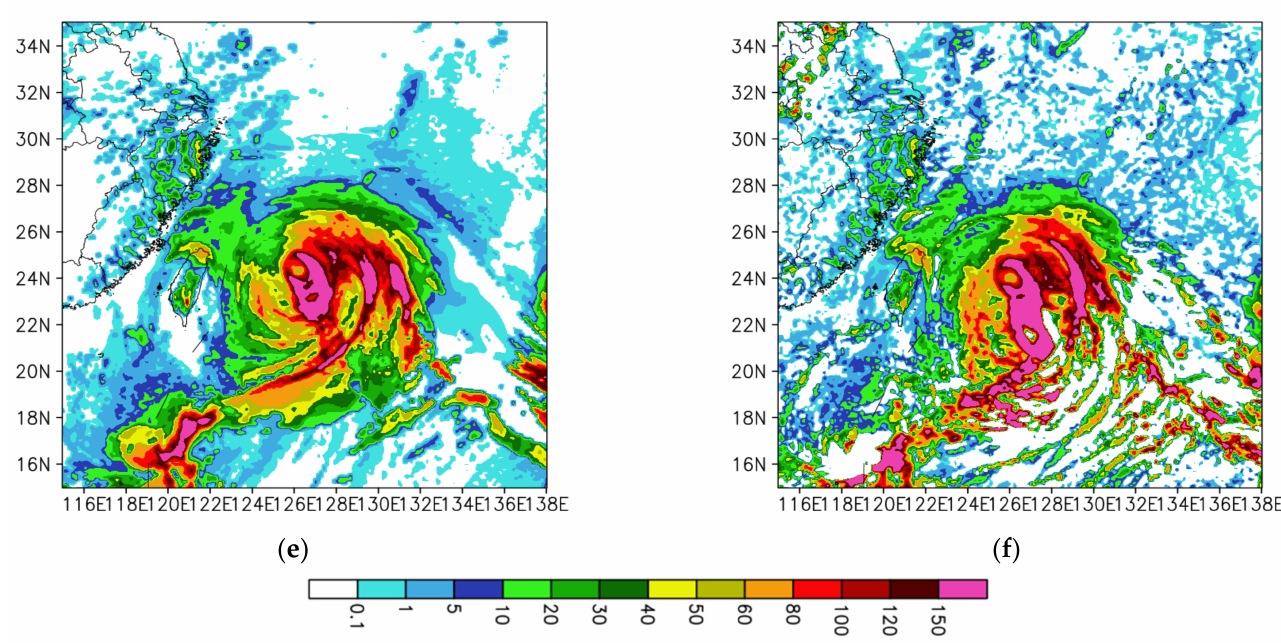
Figure 15. ( a ) The observed total accumulated rainfall (mm) from 0000 UTC to 1200 UTC 08 August 2019 and the corresponding forecast rainfall of the five experiments: ( b ) CDA-3, ( c ) CDA-2, ( d ) CDA-1, ( e ) SDA, and ( f ) NDA.